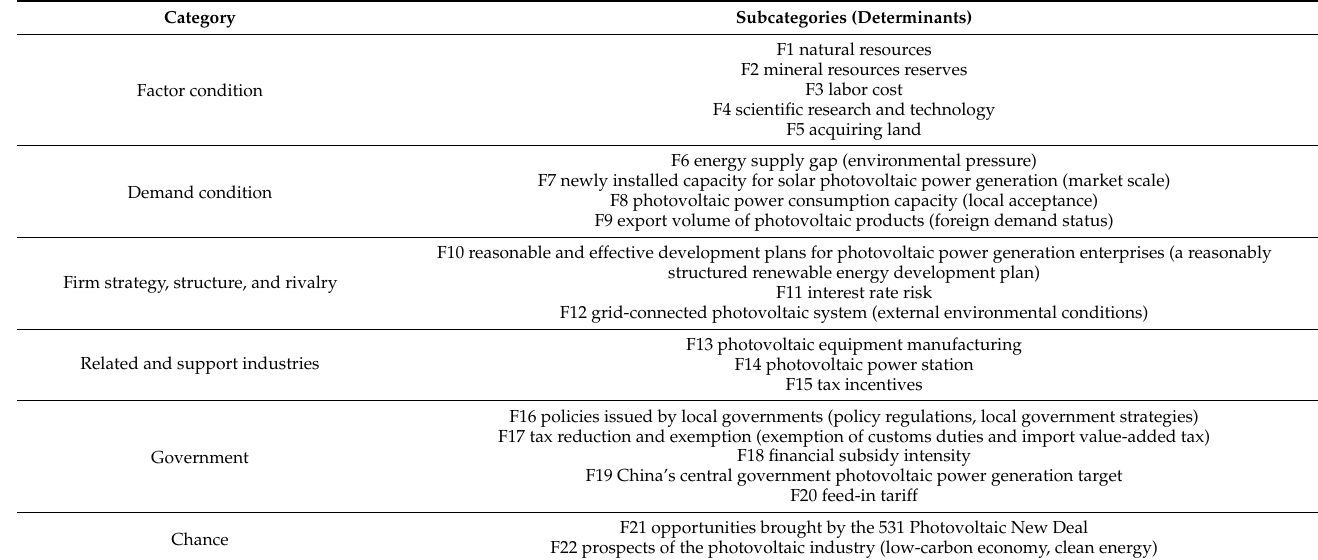
Table 5. Summary of the classification of